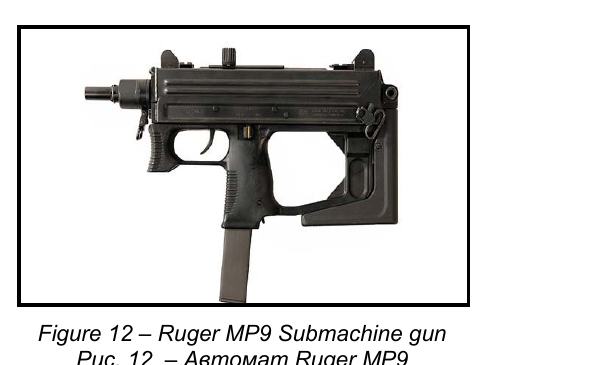
Figure 12 – Ruger MP9 Submachine gun Рис . 12 – Автомат Ruger MP9 Слика 12 – Аутомат Ruger